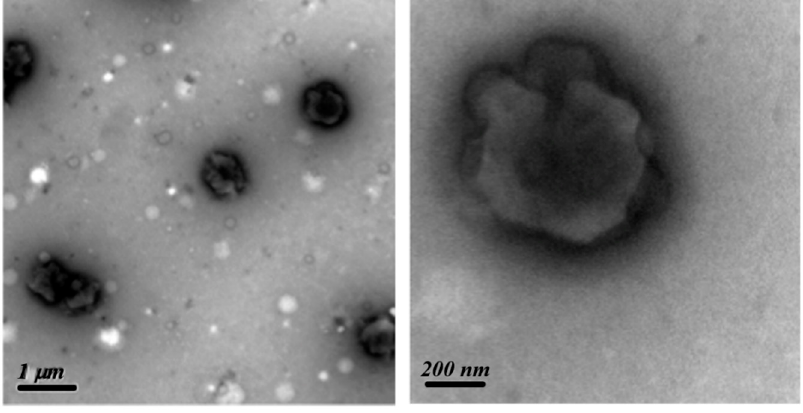
Figure 7. TEM images of PS- b -PIN with RuO 4 stained.